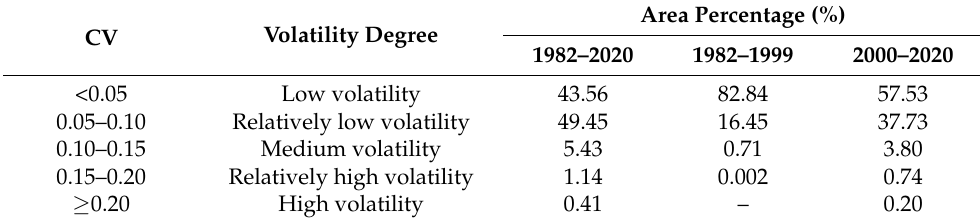
Table 2. Coefficient of variation of NDVI in the UWNR.